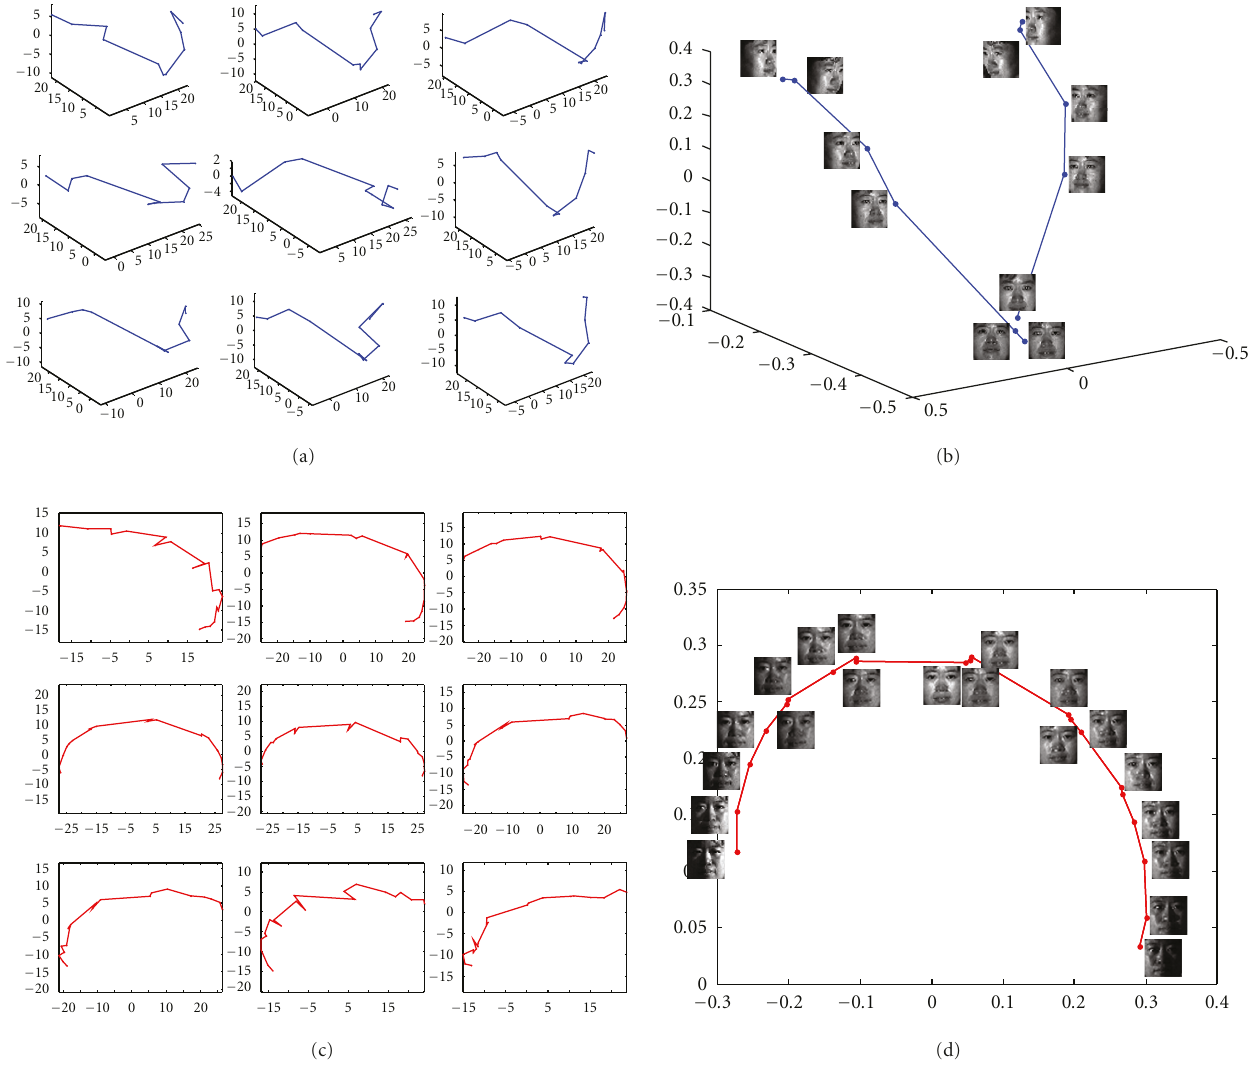
Figure 3: Low-dimensional representations of training images obtained by PCA and MPCA. (a) the PCA projections of 9 subjects’ face images generated by varying viewpoints under one lighting condition. (b) the viewpoint parameters obtained by MPCA. (c) the PCA projections of 9 subjects’ face images generated by varying lighting conditions under one viewpoint. (d) the lighting parameters obtained by